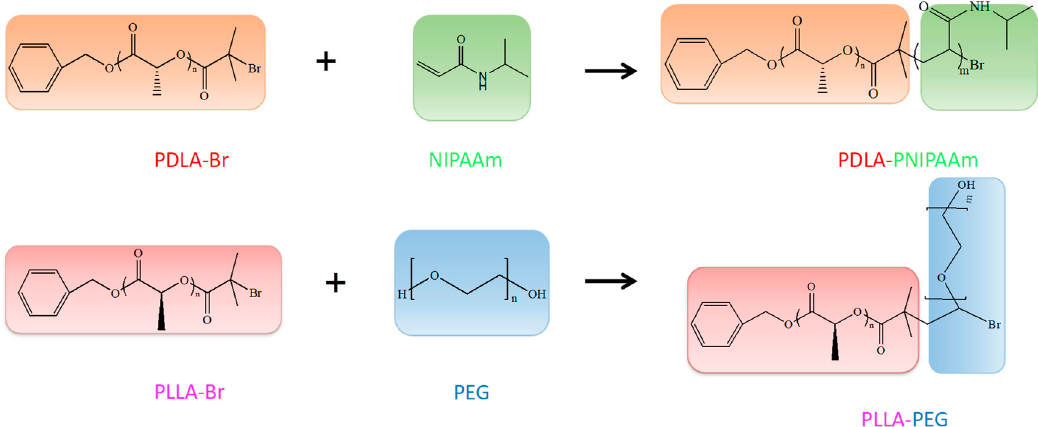
Figure 1. (Poly(ethylene glycol)-poly( L -lactic acid))/(poly( D -lactic acid)-poly( N -isopropylacrylamide)) (PEG-PLLA/PDLA-PNIPAM) synthetic roadmap.